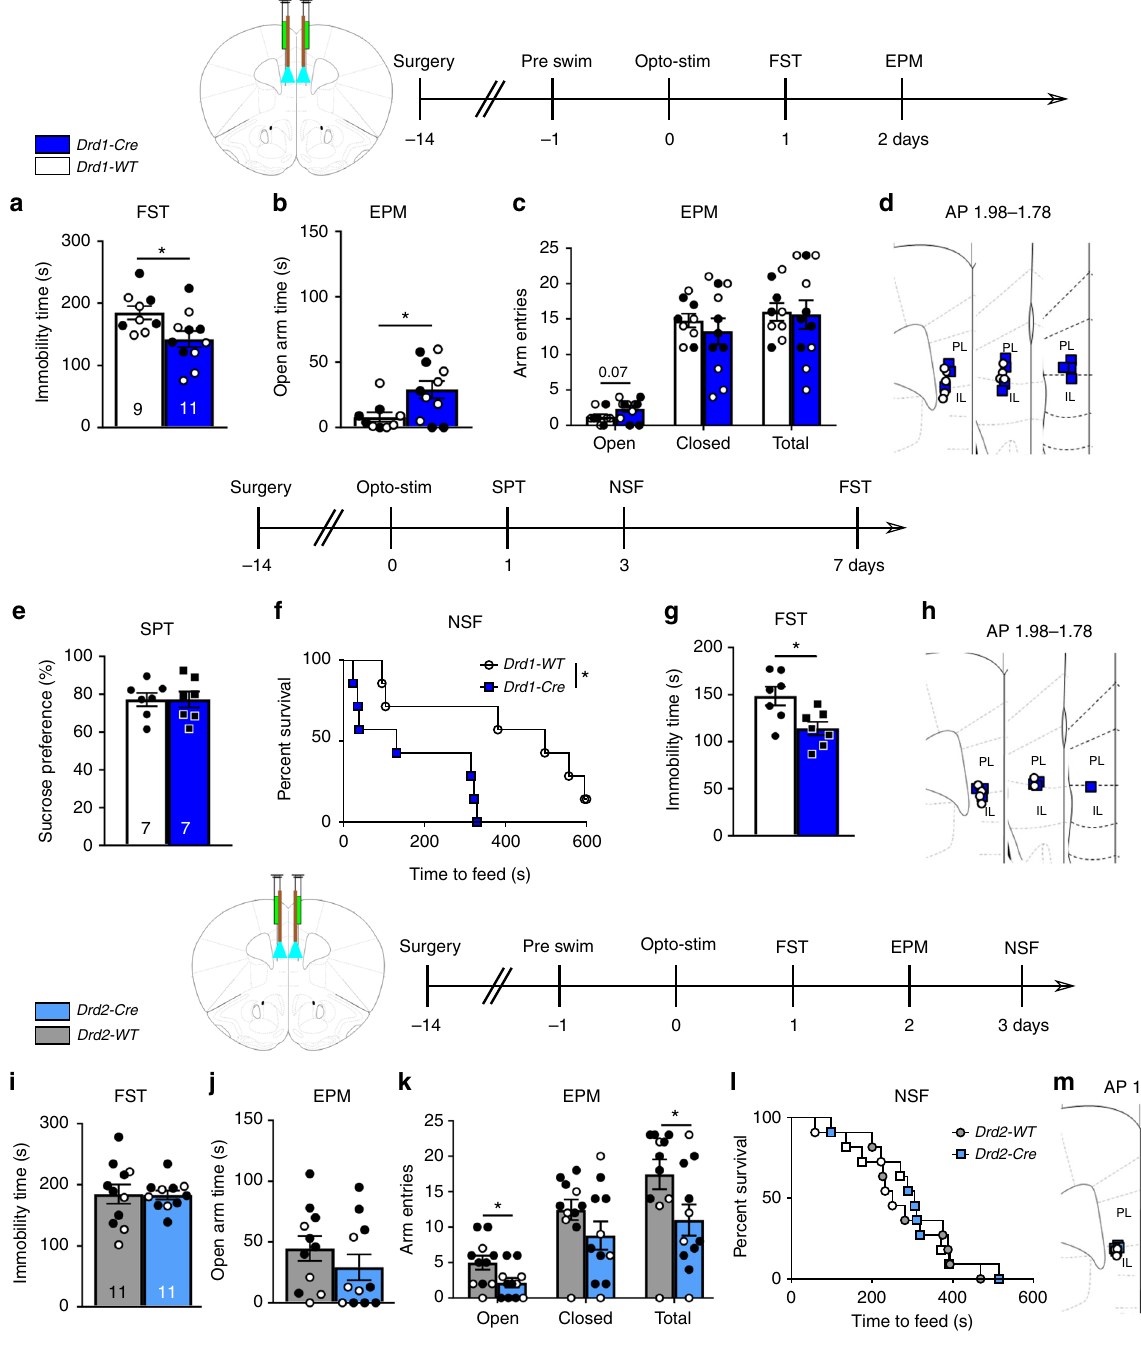
Fig. 2 Antidepressant effect of prior stimulation of mPFC Drd1 expressing cells. a Drd1-Cre forced swim immobility 24 h after photostimulation (unpaired t -test, p < 0.05). b , c Drd1-Cre elevated plus maze open arm exploration time and arm entries 48 h after photostimulation (unpaired t -test, p < 0.05). d Fiber optic cannula placements for photostimulation of Drd1-Cre mice. e Drd1-Cre sucrose preference outcome 24 h after